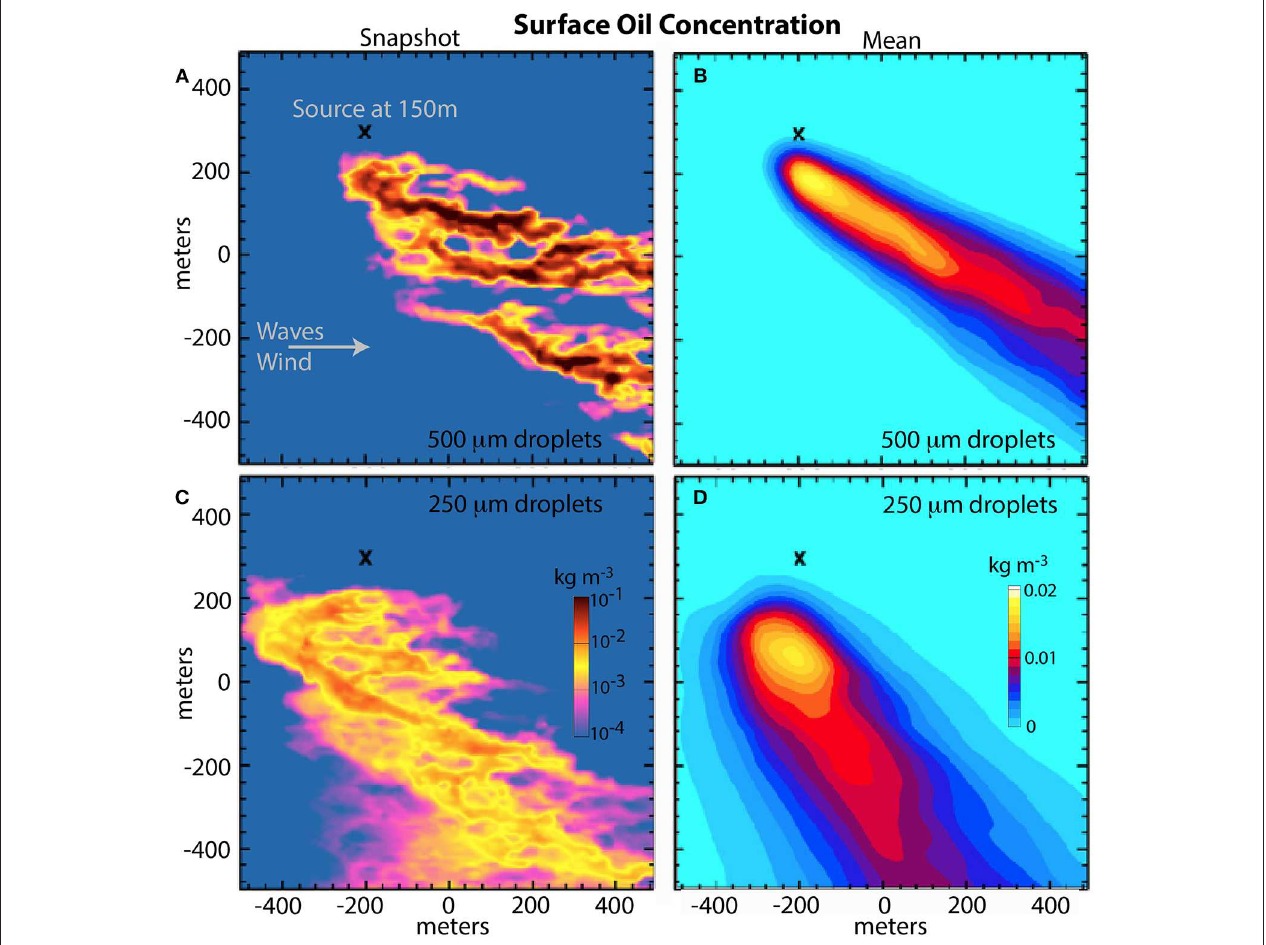
FIGURE 13 | Simulated surface oil concentration (colors) for two different oil droplet sizes emitted from a subsurface source (“x”). Left column (A,C) shows instantaneous concentration; right column (B,D) shows average concentration. Top row (A,B) simulates droplets with 500 µ m diameter rising at 22 mms − 1 ; bottom row (C,D) 250 µ m diameter rising at 5 mms − 1 . The instantaneous plume concentrations in (A,C) were sampled at t = 54,200 s. The averaged concentrations in (B,D) were obtained by averaging 175 instantaneous concentration fields sampled from t = 54,200 s to t = 89,000 s with a constant time interval of 200 s (from Yang et al.,